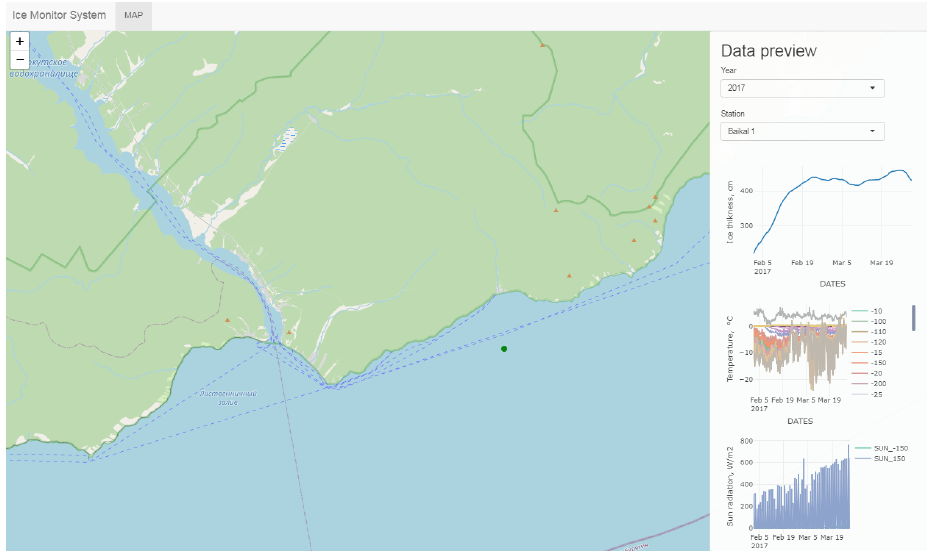
Figure 1. An example of a webpage of the server with a preview of the dataset from one of the